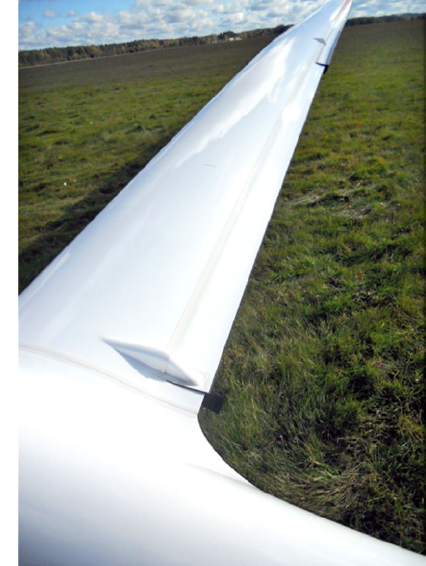
Fig. 7. VGMF extended position (Photo: P.